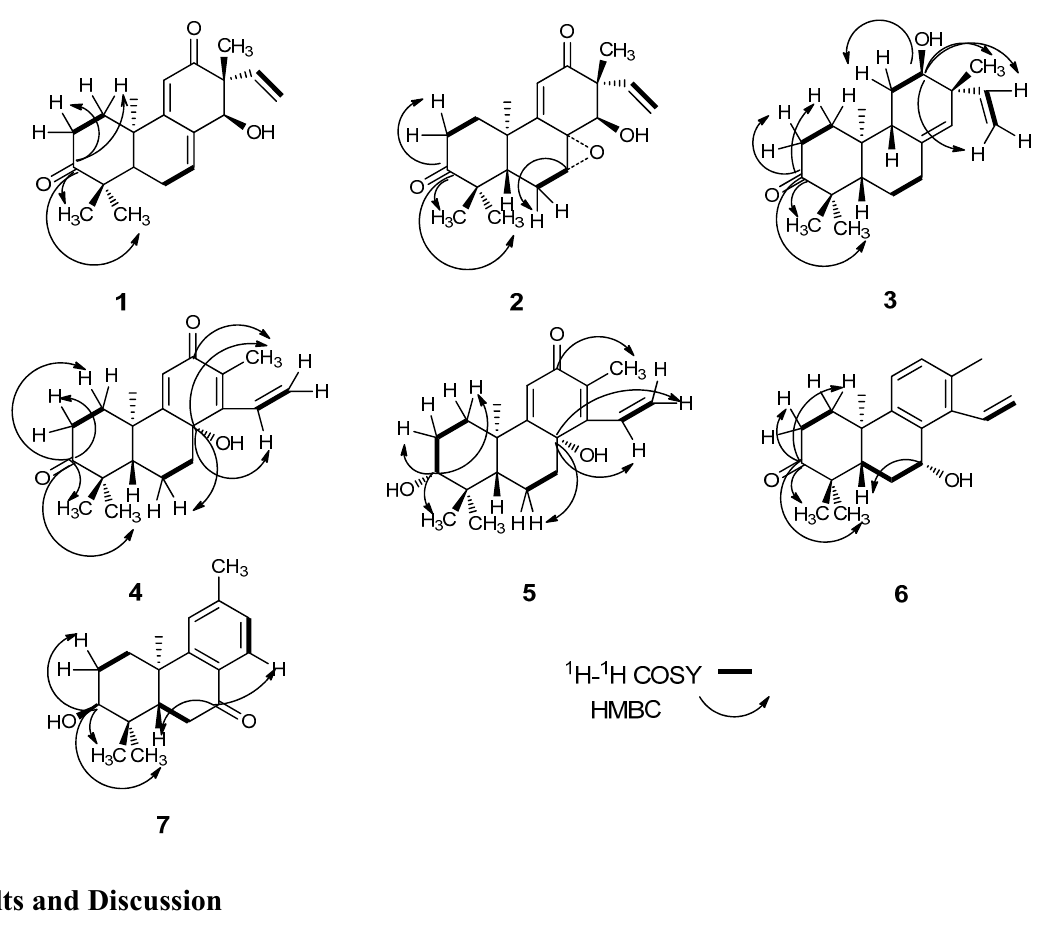
Figure 2. Main 1 H- 1 H COSY and HMBC correlations of compounds 1 – 7